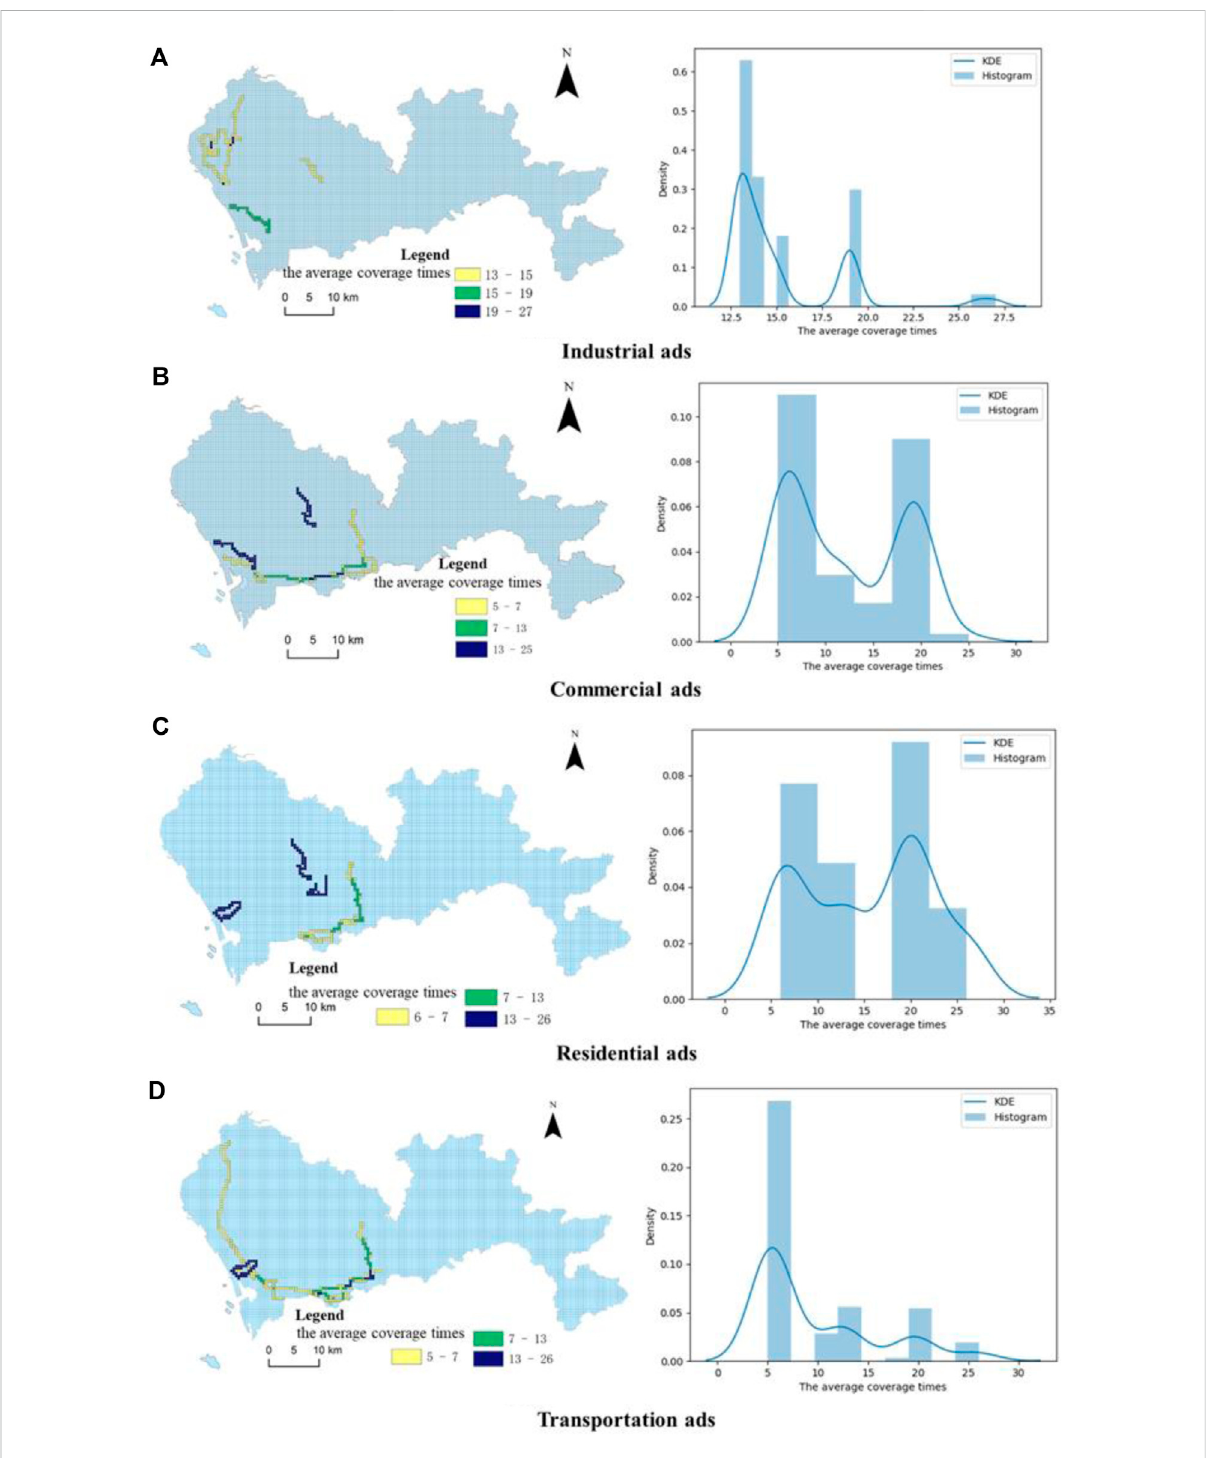
FIGURE 10 The average coverage times of each grid for (A) Industrial ads, (B) Commercial ads, (C) Residential ads, (D) Transportation